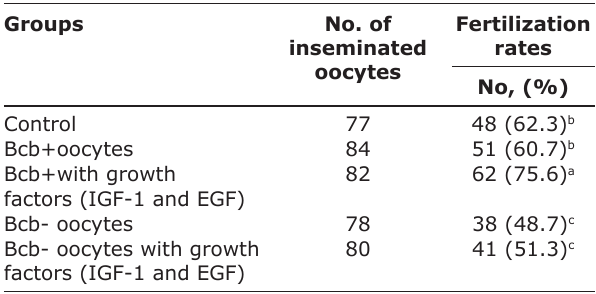
Table-2: Effect of addition of growth factors during IVM of BCB selected oocytes on the fertilization